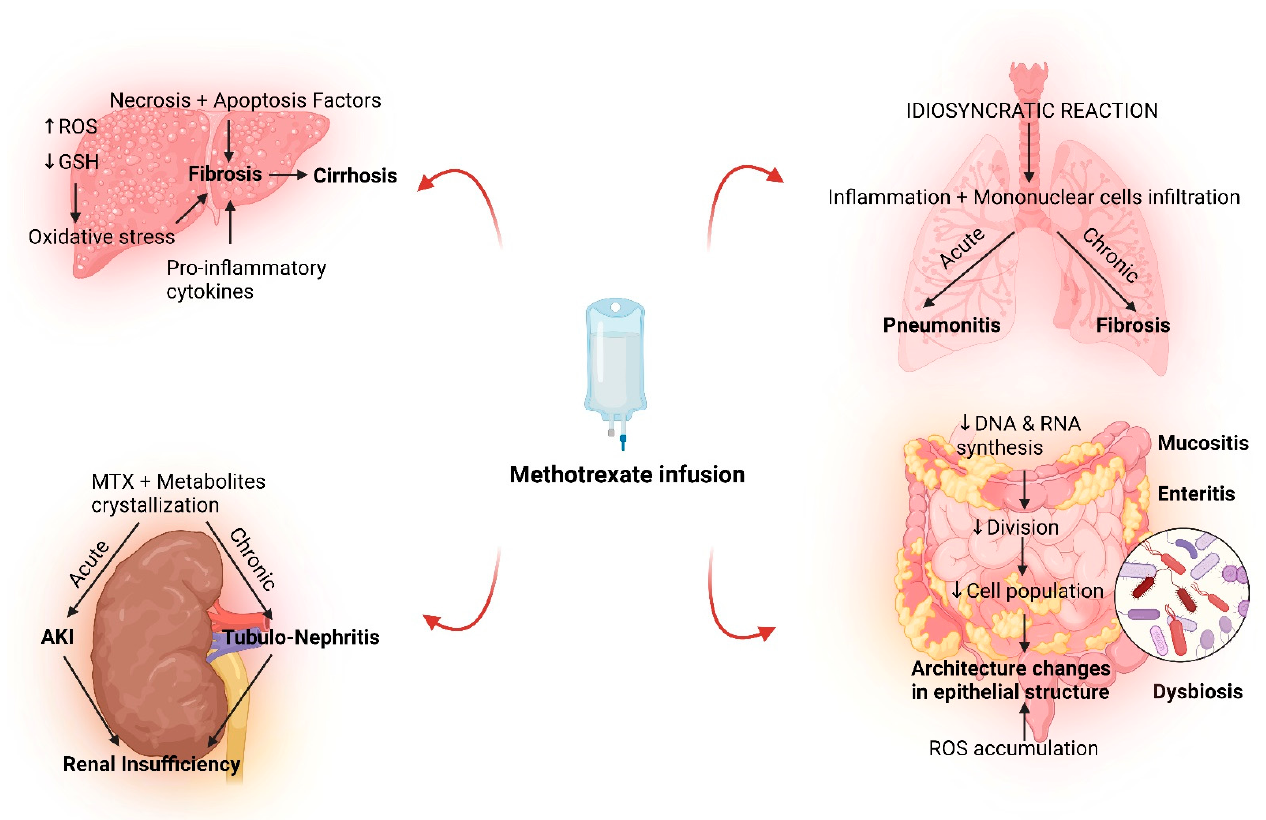
Figure 1. The main mechanisms of MTX toxicity in experimental disease models of organ